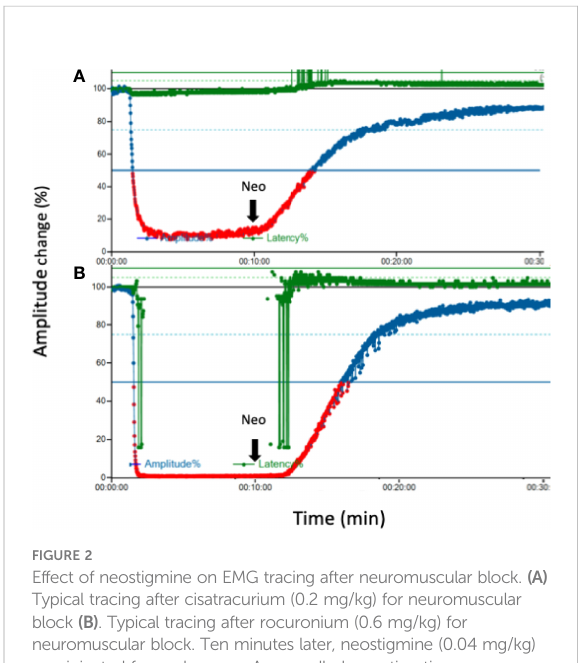
FIGURE 2 Effect of neostigmine on EMG tracing after neuromuscular block. (A) Typical tracing after cisatracurium (0.2 mg/kg) for neuromuscular block (B) . Typical tracing after rocuronium (0.6 mg/kg) for neuromuscular block. Ten minutes later, neostigmine (0.04 mg/kg) was injected for each group. An overall observation time was 30 min in each experiment. EMG, electromyography; Neo,